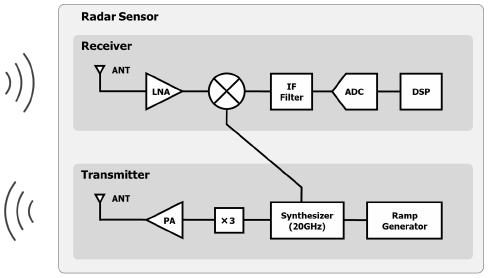
Figure 2. The architecture of the radar sensor: ANT = antenna, LNA = low-noise amplifier, PA = power amplifier, IF = intermediate frequency, ADC = analog-digital converter, and DSP = digital signal